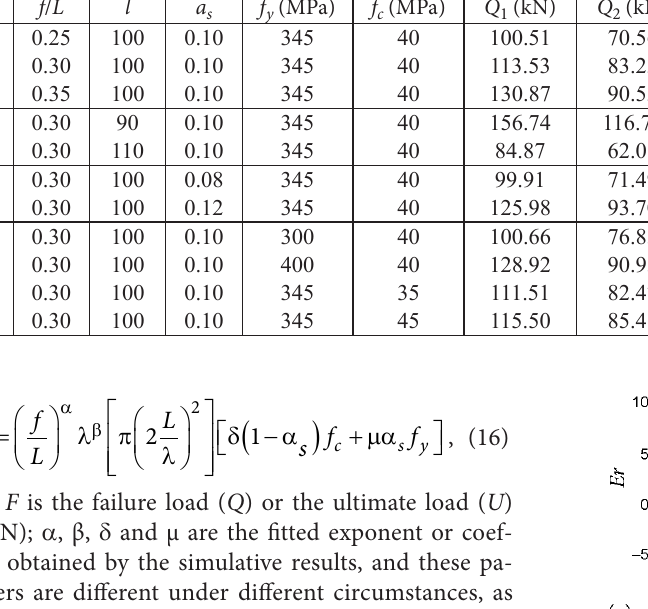
Table 2. The parameters, failure loads and ultimate loads of the simulative CFST arches No.